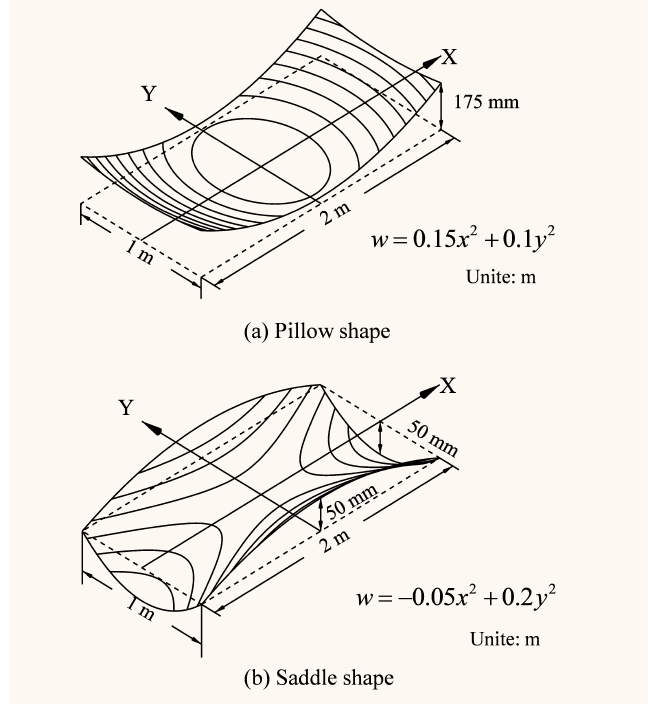
Figure 9. Surface shape with contour line ( a ) pillow shape, ( b ) saddle shape.